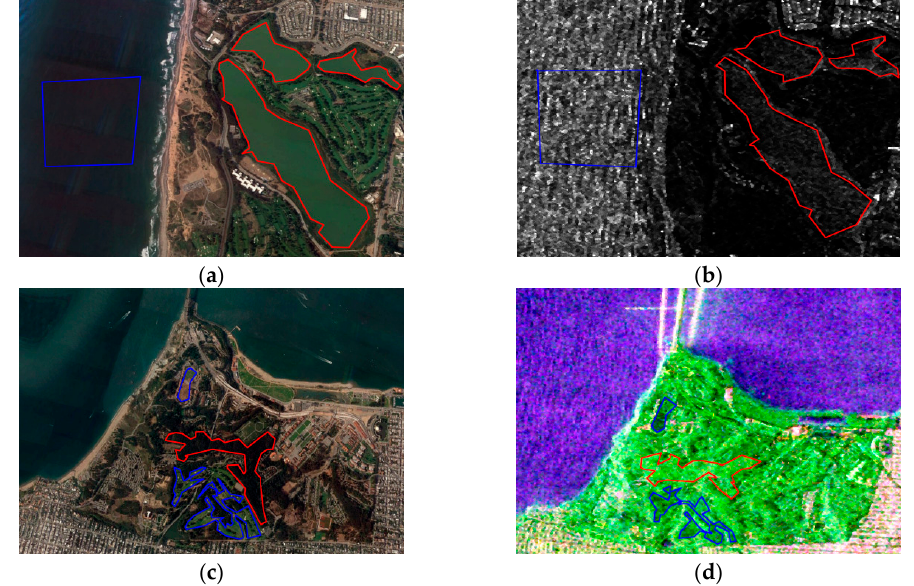
Figure 5. ( a ) Google Earth image of the area marked with the yellow boundary in Figure 4a; ( b ) corresponding span of polarimetric synthetic aperture radar (SAR) image; ( c ) Google Earth image of the area marked with a green boundary in Figure 4a; and ( d ) related polarimetric SAR image.